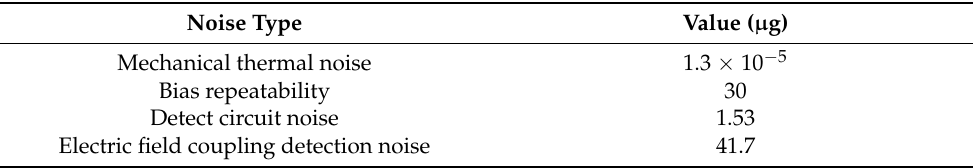
Table 7. Comparison of different types of noise values in QFA system.